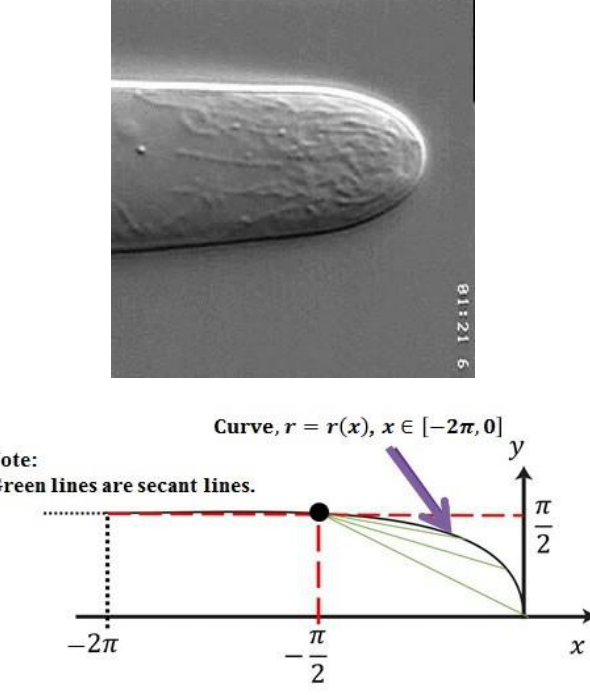
Figure 1: Left: A filamentous fungus known as Allomyces macrogynus. Taken from [14] with kind permission. Right: Half the contour of cross- section of the approximate idealized hyphal contour denoted by r(x) and associated secant lines